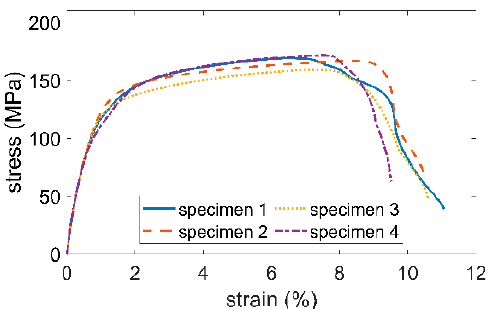
Figure 7. Results of the tensile tests on four samples from the recycled semi-finished product made of EN-AW-6060 extruded at a speed of 6 rpm and the reference specimen. Table 2. Mechanical properties of the recycled wires and the average value of the reference specimen in